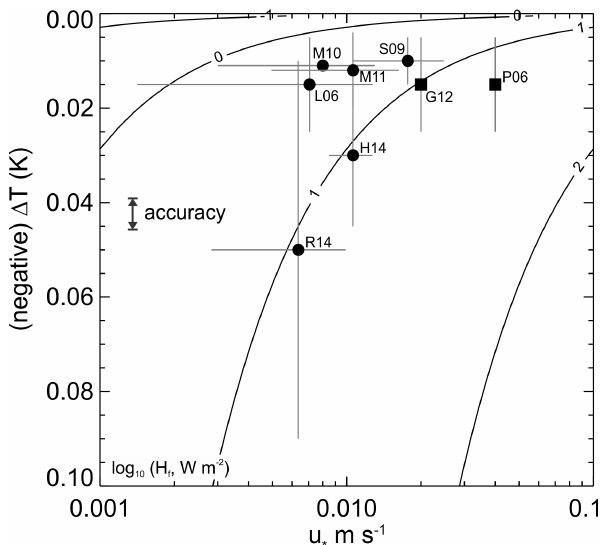
Figure 7. Contours of log 10 of heat flux H f , as a function of friction speed u ∗ and thermal driving (cid:49)T , for present c H estimate. Contours describe Eq. (6). Circles are from measurements of u ∗ and (cid:49)T , (L06, Leonard et al., 2006; S09, Stevens et al., 2009; M11, Ma- honey et al., 2011; H14, Hughes et al., 2014; R14, Robinson et al., 2014; and M10, this study). The error bars represent degree of vari- ability. The u ∗ were either directly measured (i.e. M10) or inferred from flow U using a drag coefficient whereby u ∗ = (C d ) 1 / 2 U . The squares are from observations inferring heat flux so that u ∗ is cal- culated given observed (cid:49)T (P06 Purdie et al., 2006; G12 Gough et al.,